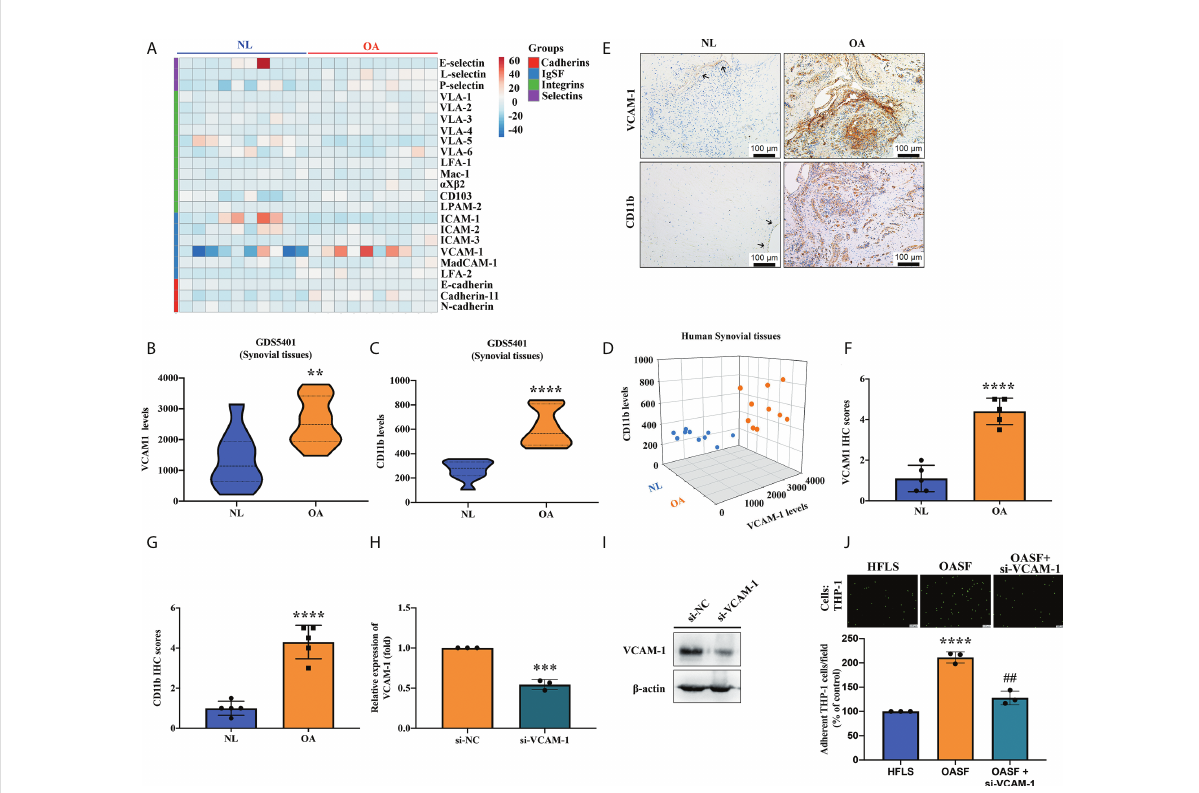
FIGURE 1 VCAM-1 expression is positively correlated with CD11b expression in OA synovial tissue. (A) A cluster heat map generated by a bioinformatics tool used data from the Gene Expression Omnibus (GEO) dataset GDS5401 for analyzing patterns of CAM expression (cadherins, IgSF, integrins, and selectins) in synovial tissue samples (OA patients, n = 10; healthy normal controls, n = 10). (B, C) The same dataset was used to analyze expression of VCAM-1 and CD11b in the 10 human OA and 10 normal healthy synovial tissue samples. (D) The 2D scatter plot displays the positive relationship between VCAM-1 and CD11b levels in synovial tissue from the 10 OA patients and the 10 healthy normal donors. (E) IHC staining was performed to examine levels of VCAM-1 and CD11b expression in hospital samples of OA synovial tissues (n = 5) and healthy synovial tissues (n = 5). Scale bar, 100 m m. (F, G) Two independent observers scored the intensity of positive VCAM-1 and CD11b expression on a scale of 1 (weak) to 5 (strong). (H, I) OASFs were transfected with VCAM-1 siRNA for 24 h, then VCAM-1 mRNA and protein levels were quanti fi ed by RT-qPCR (n = 3) and Western blot (n = 3). (J) Monocytes were labeled with green fl uorescence (BCECF-AM) for 1 h, then incubated with OASFs for 1 h. Monocytes were photographed under fl uorescence microscopy. The images were quanti fi ed for adherent cells using ImageJ software in three independent experiments. LFA, lymphocyte function- associated antigen; VLA, very late antigen; Mac-1; macrophage-1 antigen; CD103, cluster of differentiation 103; LPAM-2, lymphocyte Peyer ’ s patch adhesion molecule 2; ICAM, intercellular adhesion molecule; VCAM; vascular cell adhesion protein; MAdCAM-1; mucosal vascular addressin cell adhesion molecule 1; OASF; osteoarthritis synovial fi broblast; HFLS, human fi broblast-like synoviocyte. ** p < 0.01, *** p < 0.001 and **** p < 0.0001 compared with healthy normal controls; ## p < 0.01 compared with